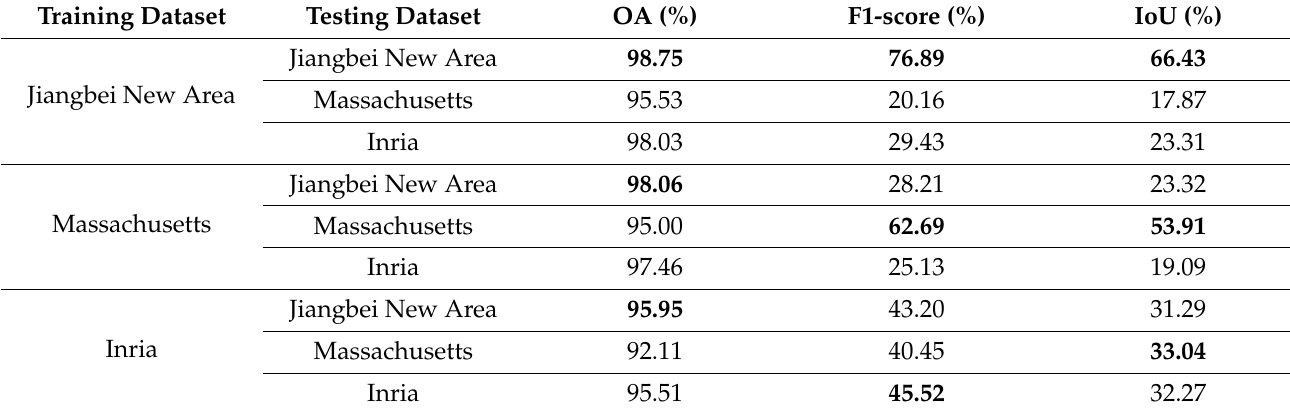
Table 9. Cross-dataset evaluation results of ME-Net, the best values of each training dataset are masked as bold. Training